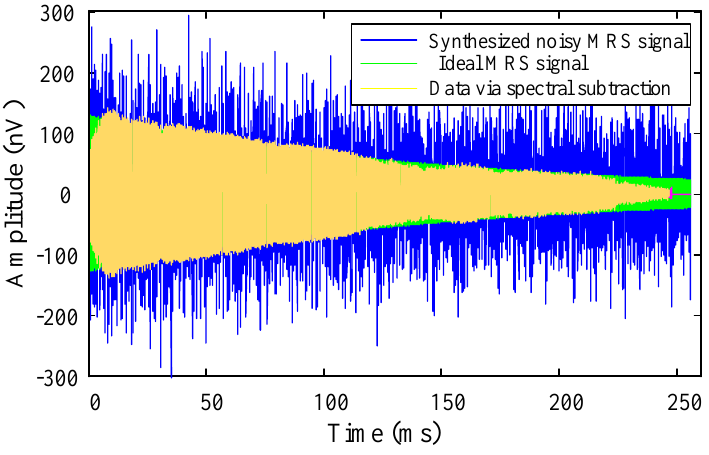
Figure 8. Noise suppression result using DA-MFSS.